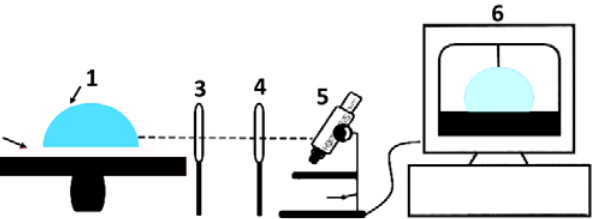
Figure 9. Hydrophilicity measurement; (1) drop on the specimens, (2) substrate of coating, (3,4) con- vex double lenses, (5) Guppy CMOS camera for detecting, and (6) software system.